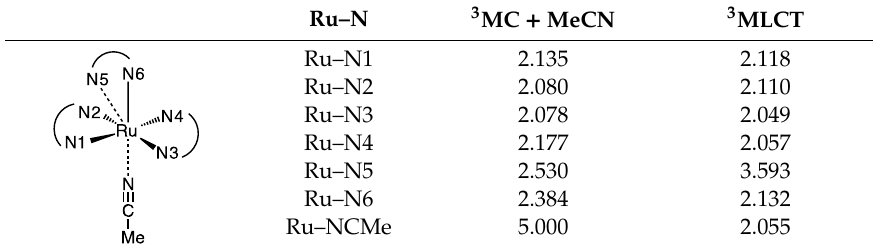
Table 1. Atom numbering and Ru–N distances (Å) at the start ( 3 MC + MeCN) and end ( 3 MLCT) points of the computed reaction path. Ru–N 3 MC +